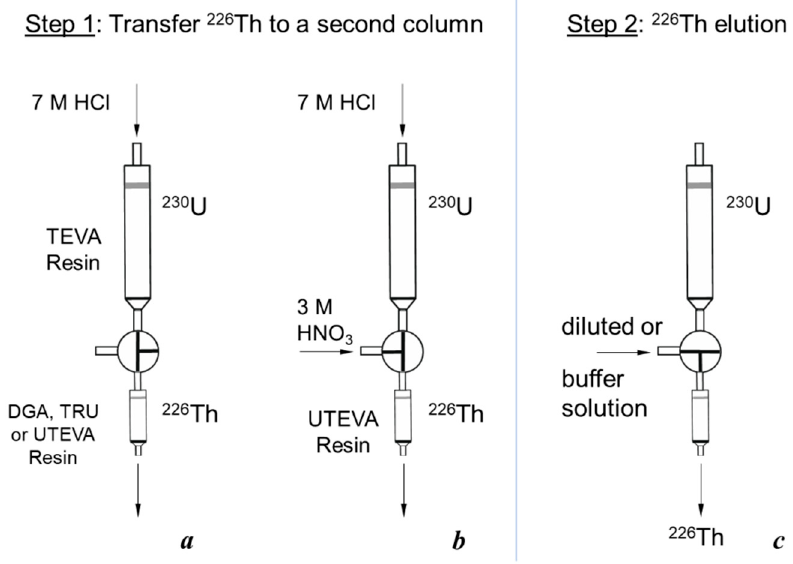
Figure 4. Scheme of 226 Th production by a two-column 230 U/ 226 Th generator: ( a , b ) Two modifications of transferring 226 Th from the parent 230 U column to a second one; ( c ) elution of 226 Th from the second column.